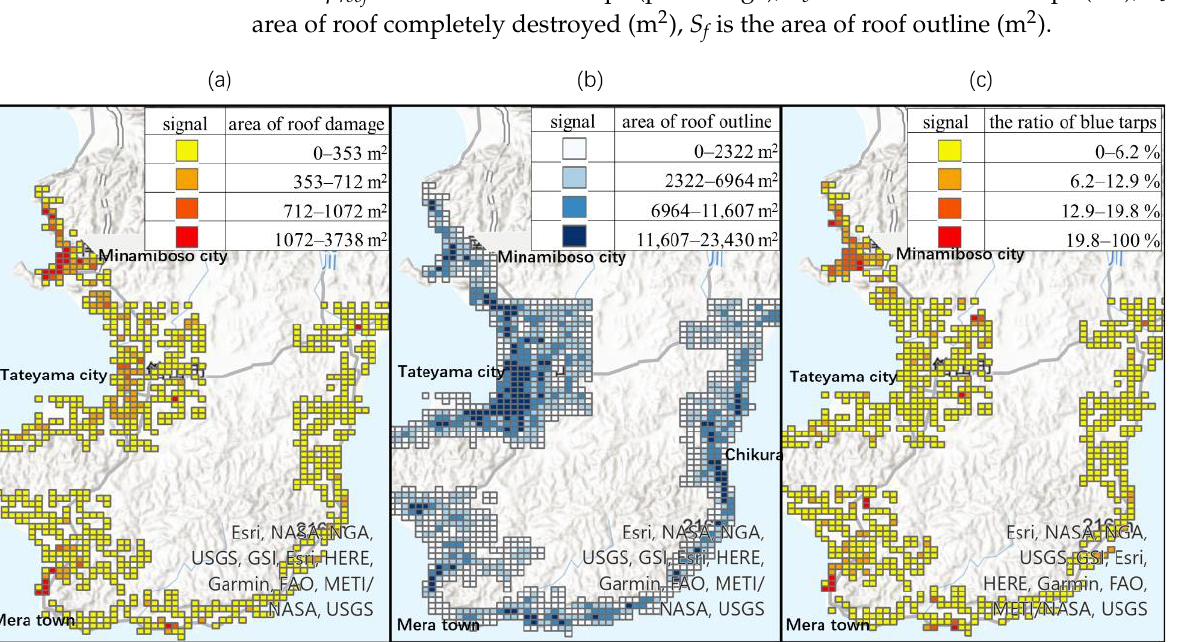
Table 7. Comparison with other classification